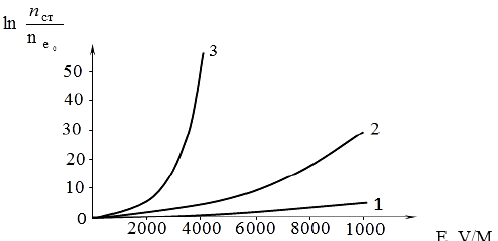
Fig. 2. Dependence of the logarithm of the ratio of the electron density to the electric field strength for times: 1 – 0.01; 2 – 0.1; 3 – 1 in fractions of the pulse duration t р =3 ns It is established that the breakdown intensity of the electric field depends on the initial concentration of electrons in the discharge volume and the EMR duration. When the ratio of the critical concentration to the initial concentration is changed only by a factor of 5 and the air pressure is 750 mm Hg, the breakdown strength of the field decreases from 30 kV/m to 20 kV/m. With an increase in the pulse duration by an order of magnitude, the breakdown field strength is reduced by a factor of 5 lg n cr /n e0 =20. As the EMR duration is increased by a factor of 10, the breakdown strength of the electric field decreases by a factor of 3. 2. The case of a solid-state plasma medium. The dependence of the EMR damping γ/ω on the non-equilibrium parameter is shown in Fig. 3.